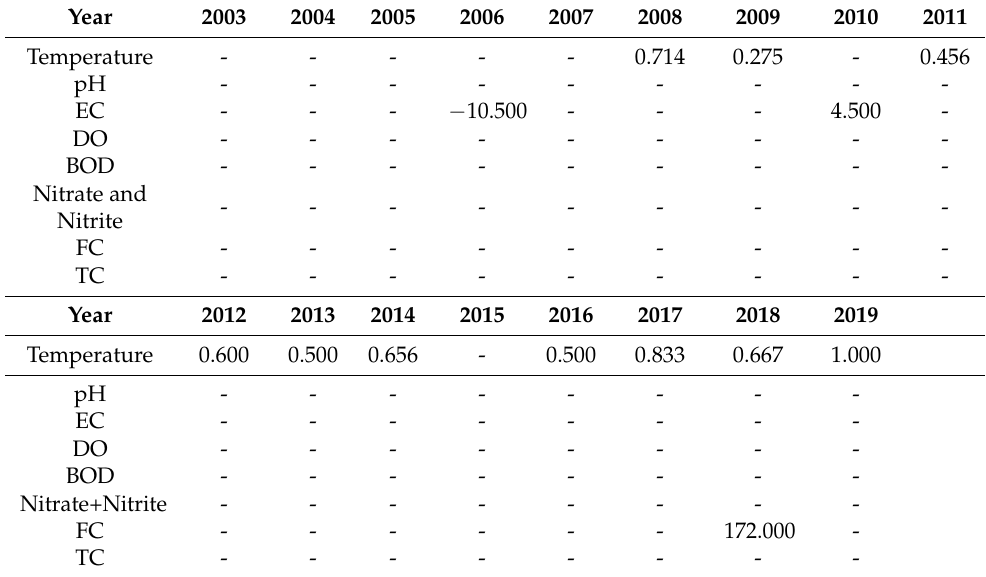
Table 2. Sen’s slope evaluation for the yearly series of water